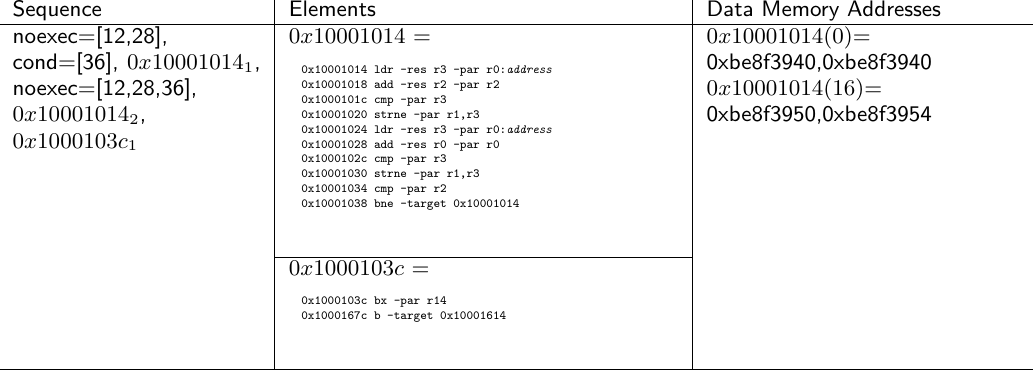
Table 1: The compressed sequence of the ITF segment in Listing 1 Once the base basic block is complete, the flag sets and